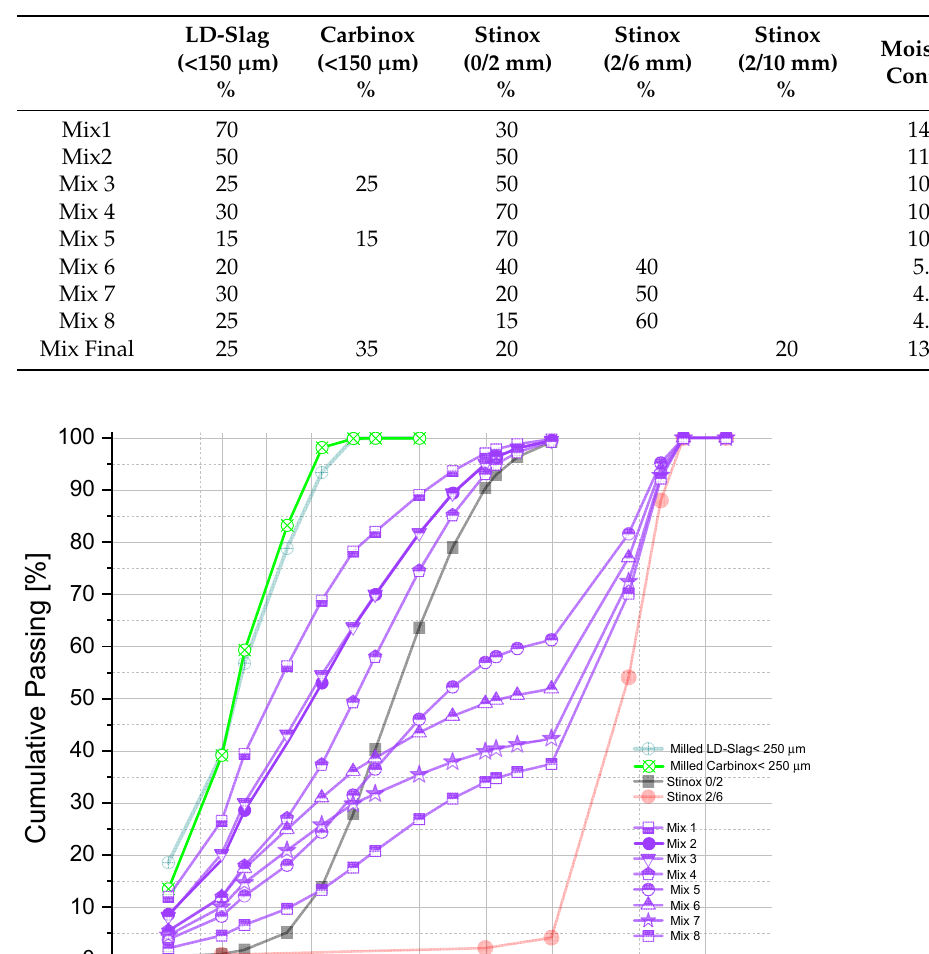
Table 2. Mixtures used to investigate the relation between compressive strength and split tensile strength. Last column in the table shows the moisture content (water/solid) ratio, to which the mixtures were brought 24 h before compaction and carbonation.